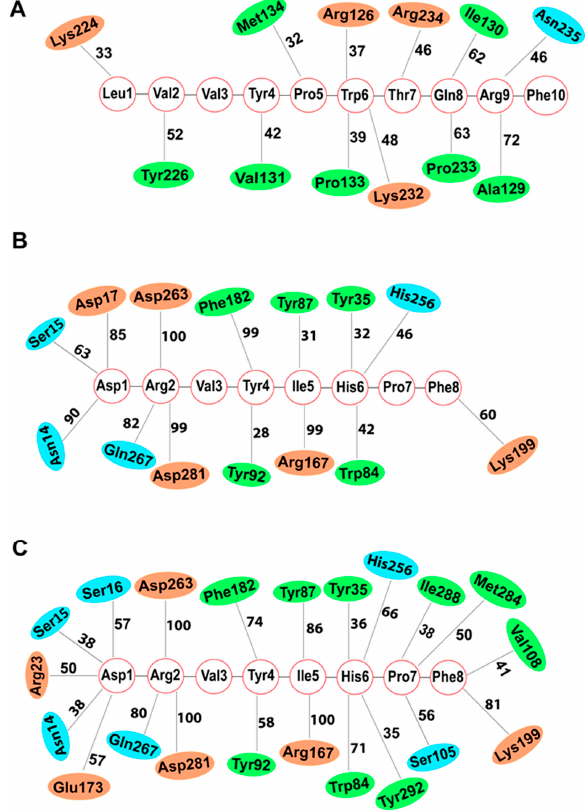
Figure 6. Average percentage of simulation time from three 500-ns runs during which AT1R residues maintained contact with LVV-H7 and AngII. The average percentage of simulation time is shown next to the line. Histograms showing the interaction contact time from each of the three simulations can be found in Supplementary Figure S2. Charged, hydrophobic, and polar residues of AT1R are represented with orange, green, and blue colors, respectively. ( A ) Average percentage of simulation time an AT1R residue maintained contact with LVV-H7, ( B ) average percentage of simulation time an AT1R residue maintained contact with AngII, and ( C ) average percentage of simulation time an AT1R residue maintained contact with AngII in the presence of